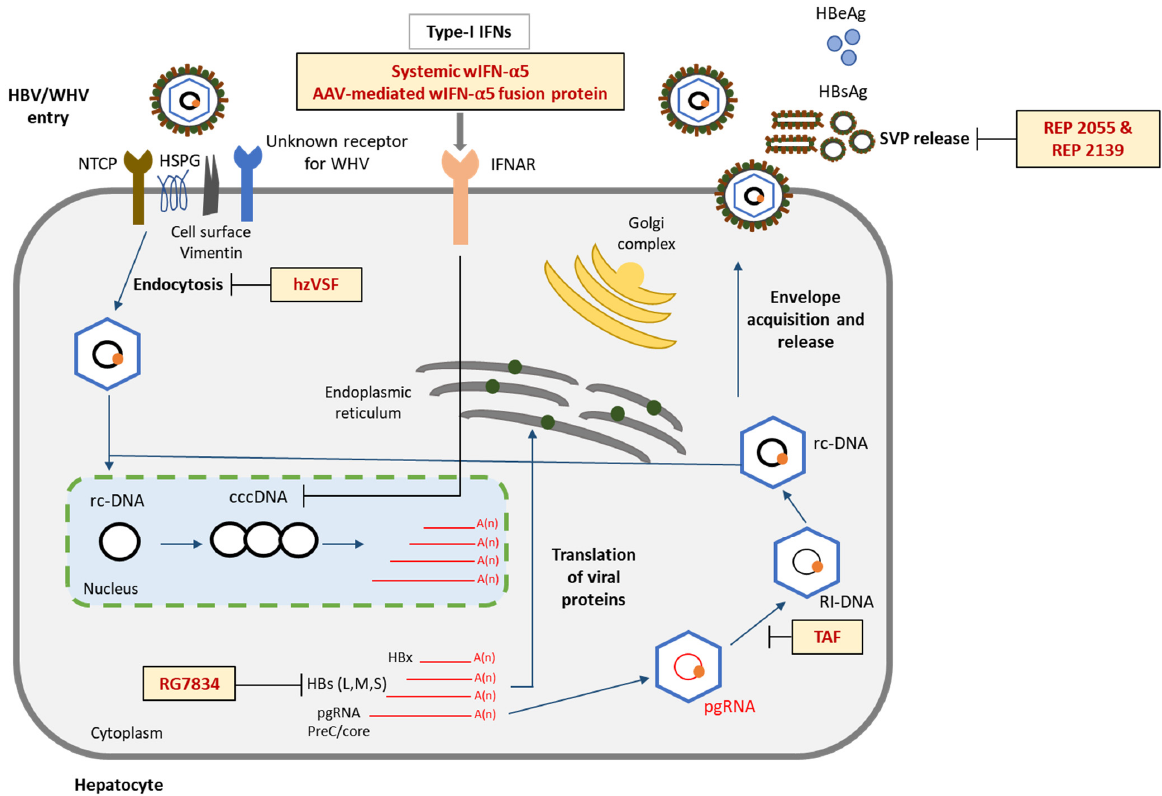
Figure 2. Antiviral drugs targeting different steps of the HBV/WHV life cycle recently tested in the woodchuck animal model of CHB. Attachment to and entry of HBV into hepatocytes is mediated by binding to HSPG and NTCP followed by a multi-step endocytosis process. Viral infection induces the expression of cell surface vimentin, which is known to support endocytosis. The monoclonal antibody hzVSF targeting cell surface vimentin inhibits the internalization and hence the endocytosis of HBV/WHV thereby acting as a viral entry inhibitor. RG7834 is a small molecule inhibitor of HBV gene expression that targets the poly (A) polymerases PAPD5 and PAPD7 to destabilize and degrade viral RNAs, especially surface mRNA. Similar to other NAs, TAF targets the HBV/WHV polymerase and inhibits viral DNA synthesis. REP 2055 and REP 2139 are nucleic acid polymers that target the assembly of HBV subviral particles and block the release of HBsAg from infected hepatocytes. Unlike these DAAs and NAs, type-I IFNs and systemic wIFN- α 5 and AAV-mediated wIFN- α 5 fusion protein directly target the persistent viral cccDNA reservoir in the nuclei of infected hepatocytes. See text for details. Abbreviations: A(n), viral RNAs containing a poly-adenine tail; AAV, adeno-associated virus; cccDNA, covalently closed circular DNA; HBeAg; HBV e antigen; HBs, HBV surface gene encoding for the large (L), middle (M), and small (S) surface antigens; HBsAg, HBV surface or envelope antigen; HBV, hepatitis B virus; HBx, HBV x gene; HSPG, heparin sulfate proteoglycans; hzVSF, humanized virus suppressing factor or viral entry inhibitor; IFN, interferon; IFNAR, interferon-alpha receptor; NTCP, sodium taurocholate co-transporting protein; pgRNA, pre-genomic RNA; PreC/core, HBV PreC/core genes; rc-DNA, relaxed circular DNA; REP 2055 and REP 2139, inhibitors of HBV subviral particle assembly and surface antigen release; RG7834, inhibitor of HBV gene expression, RI-DNA, replicative intermediate DNA; SVP, subviral particles; TAF, tenofovir alafenamide fumarate; WHV, woodchuck hepatitis virus; wIFN- α 5, recombinant woodchuck IFN- α